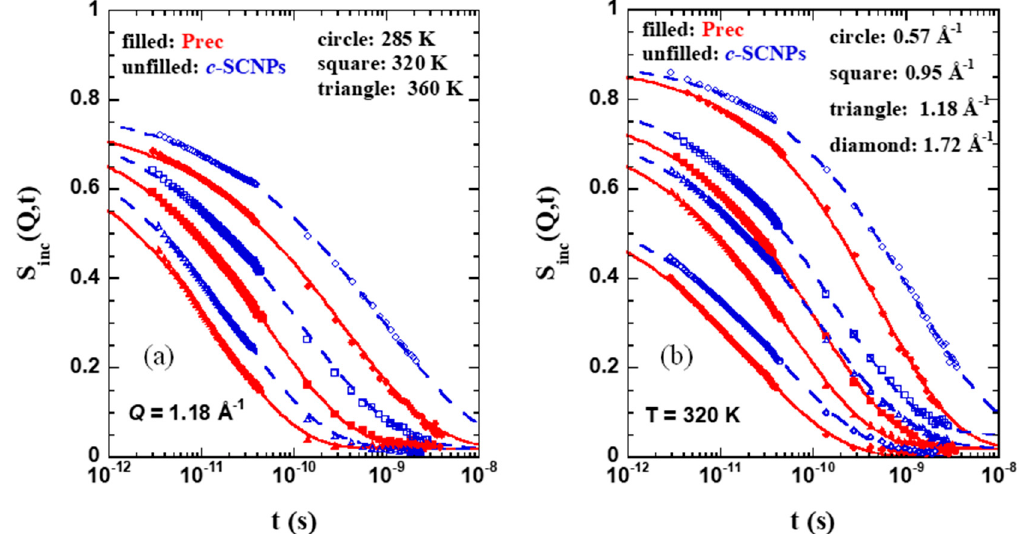
Figure 6. Fourier transformed and deconvoluted QENS spectra obtained from IN5 and IN16B on the precursor (red) and c -SCNP (blue) samples at ( a ) three different temperatures investigated: 285 K (circle), 320 K (square), and 360 K (triangle) and a Q -value of 1.18 Å − 1 ; and ( b ) for T = 320 K at four different Q -values: 0.57 Å − 1 (circle), 0.95 Å − 1 (square), 1.18 Å − 1 (triangle), and 1.72 Å − 1 (diamond). Solid lines are KWW fits with β ≈ 0.5 (exact values shown in Figure 7b) to the results above 2 ps.